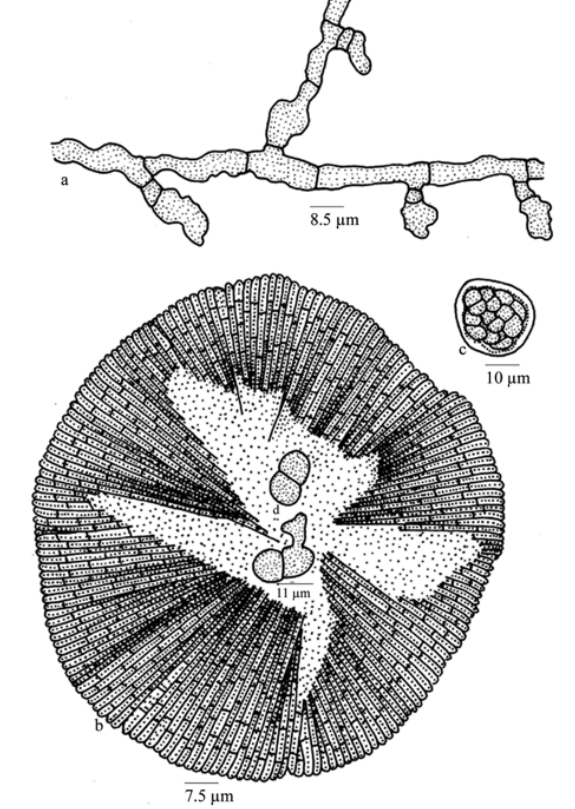
Figure 161. Asterina piperina a - Appressorium; b - Thyriothecium; c - Ascus; d - Ascospores